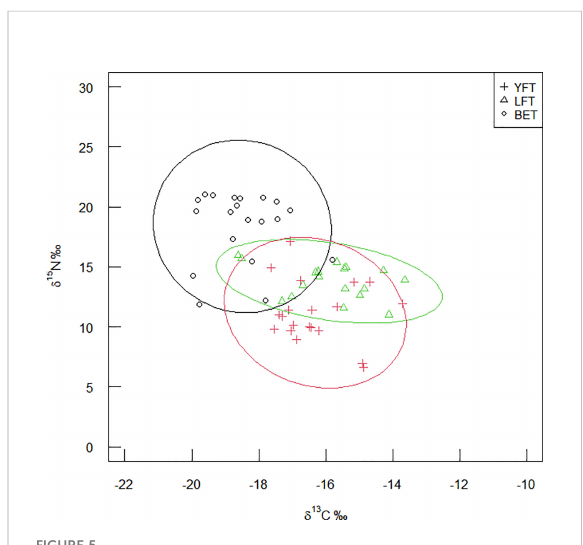
FIGURE 5 Trophic structure of three species of tuna. BET, big eye tuna, Thunnus obesus ; YFT, yellow fi n tuna, T. albacares ; LFT, albacore tuna, T. alalunga .